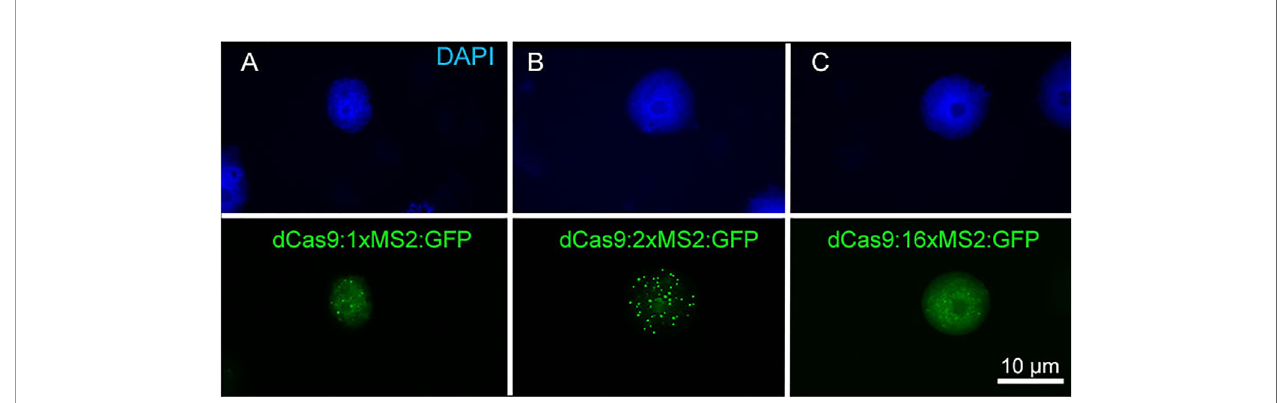
FIGURE 5 | Effect of MS2 aptamer copy number of aptamer-based CRISPR imaging constructs on signal intensity. (A) dCas9:1xMS2, (B) dCas9:2xMS2, and (C) dCas9:16xMS2. The construct with two copies of MS2 revealed the best labeling of telomeres. Nuclei are counterstained with